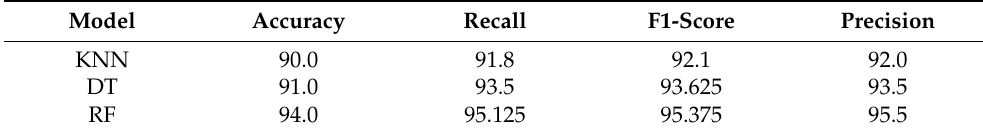
Table 6. Measurement results for ML classifiers.